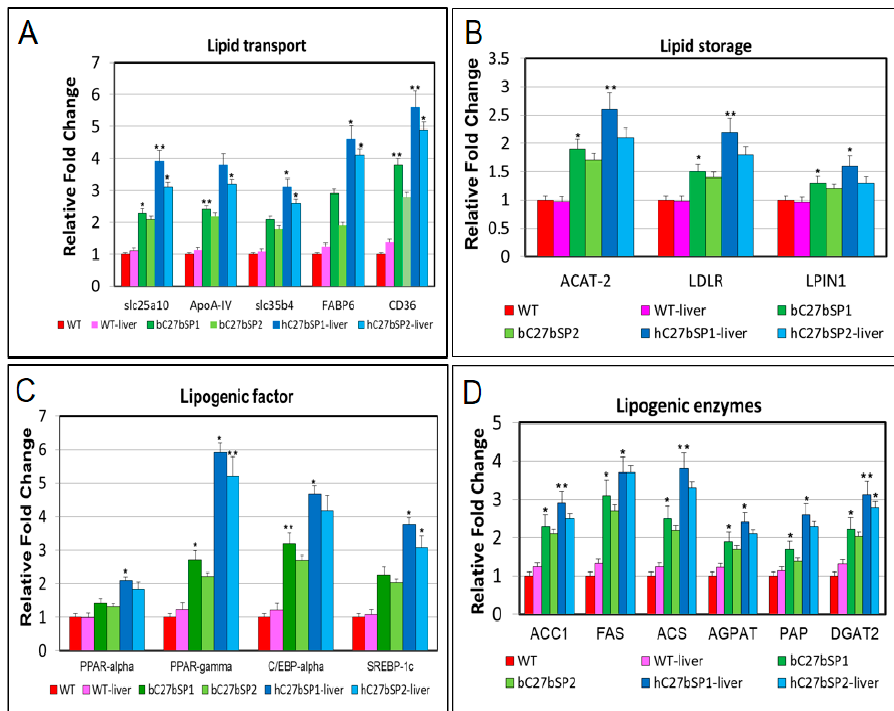
Figure 4. RT-qPCR analysis of selected lipogenic genes in bC27bSPs larvae and livers of hC27bSPs larvae. The relative mRNA expression of lipid transport ( A) lipid storage ( B ), lipogenic factor ( C ), and lipogenic enzyme ( D ) genes in C27bSPs compared with gene expression in WT fish. The qRT-PCRs were performed in triplicate. Expression analysis of the selected genes using cDNA prepared from average four months male–female fish pairs per groups. Values were normalized against β -actin. The asterisk represents statistically significant differences; * p < 0 .01, and ** p < 0.005 levels as compared to control. Int. J. Mol. Sci. 2018 , 19 , 93